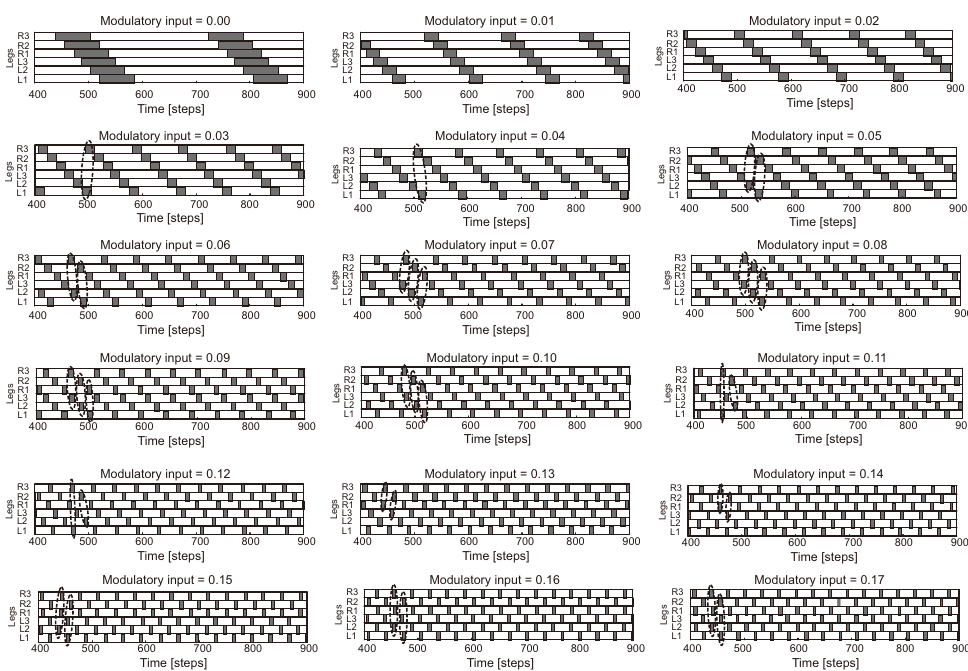
Figure 8. A variety of hexapod gaits with varying speeds generated by adaptive CPG-based neural locomotion control (modified from [142]). The frequency of the CPG outputs can be changed by modulating the synaptic connections of the CPG neurons with an extrinsic modulatory input MI . When the modulatory input MI is set to 0.0, each leg steps in a wave on each side with overlap. Stepping frequency increases as MI increases, and some legs step in pairs (see dashed enclosures). This results in insect-like gaits (Figure 5d) and various intermixed gaits. The caterpillar gait is characterized by the movement of two front, middle, or hind legs at the same time and the wave travels from back to front. Under this control approach, a transition gait as shown in Figure 5d is not found. For example, one can observe wave gaits with varying frequencies ( MI = 0.01–0.04), tetrapod gaits with varying frequencies ( MI = 0.05–0.06), caterpillar gaits with varying frequencies ( MI = 0.07–0.10), and tripod gaits with varying frequencies ( MI = 0.15–0.19). Legs are labeled as numbers 1–3 from front to back, and the left and right sides are L and R, respectively. It is worth noting that when MI is raised above 0.17, only two different gaits comparable to tripod gait (e.g., MI = 0.17) and caterpillar gait (e.g., MI = 0.10)